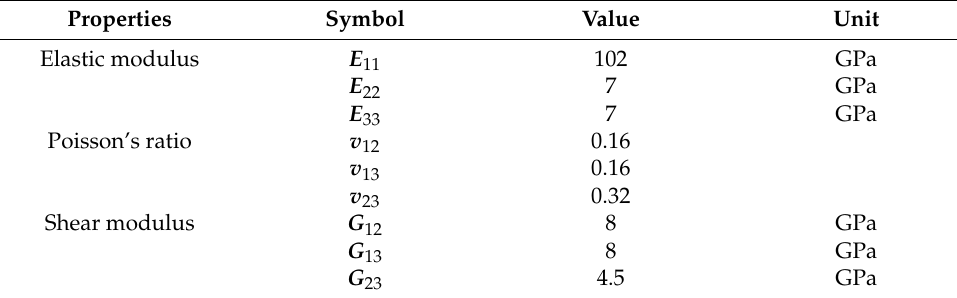
Figure 1. Composite cylindrical shells. Table 1. Properties of Carbon fiber (T700-12K)